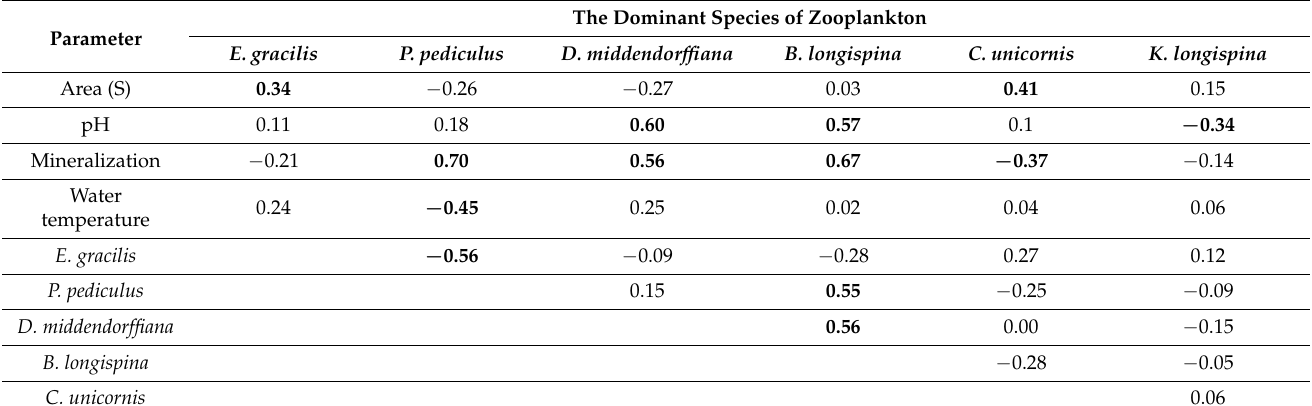
Table 4. Correlation analysis of the number of dominant zooplankton species in tundra lakes with abiotic and biotic factors.